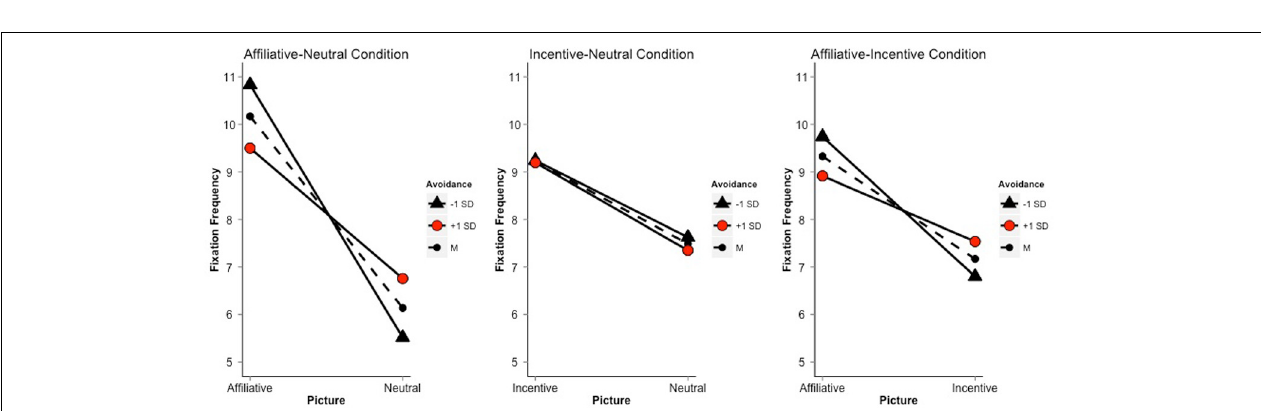
FIGURE 2 | Simple slopes of picture on fixation frequency for ± 1 SD and the mean (dashed line) of SC.